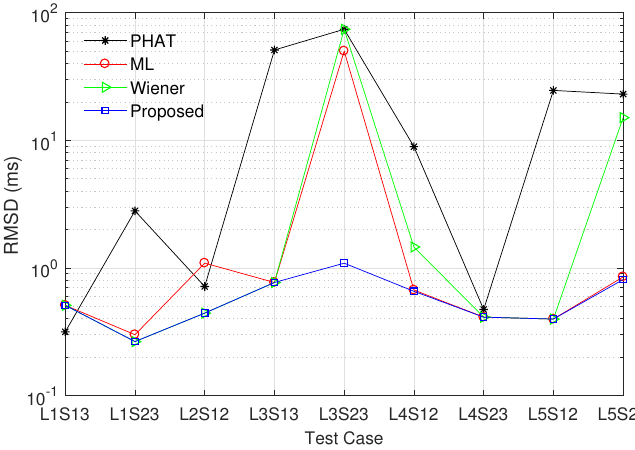
Figure 11. RMSD of various prefilters in field measurements, when α = 0.45, N = 4096, and M = 25.